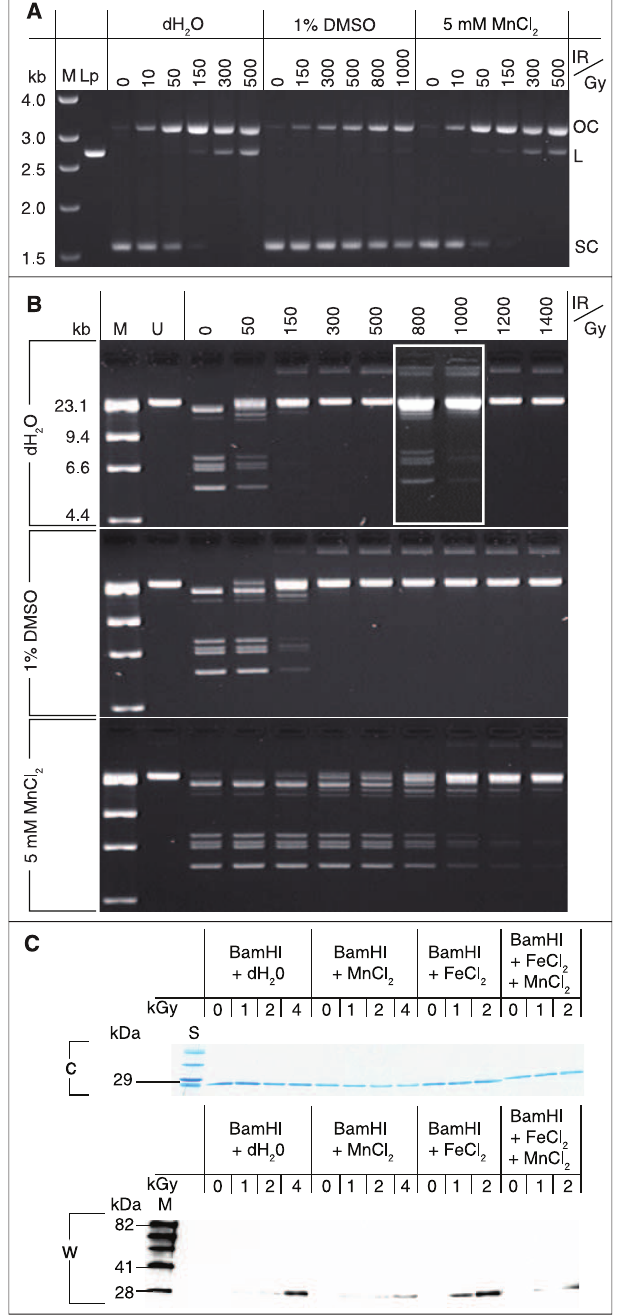
Figure 2. Mn(II) Protects Proteins, but Not DNA, during In Vitro Irradiation (A) DMSO-mediated DNA protection. pUC19 plasmid DNA was irradiated aerobically to the indicated doses in dH 2 O, 1% DMSO (HO (cid:2) scavenger), or 5 mM MnCl 2 , followed by agarose gel electrophoresis (AGE). MnCl 2 and DMSO were prepared in dH 2 O. IR, 60 Co, aerobic at 0 8 C. L, linear (2,686 base pairs); Lp, pUC19 þ BamHI; M, size markers; OC, open circular; SC, supercoiled. (B) Mn(II)-mediated protein protection. BamHI enzyme was irradiated aerobically to the indicated doses in dH 2 O, 1% DMSO, or 5 mM MnCl 2 , and then incubated with k -phage DNA for 1 h at 37 8 C, followed by AGE. Inset (white border), top gel (dH 2 O): BamHI irradiated anaerobically. M, size markers; U, uncut k -DNA. (C) Western blot immunoassay of protein-bound carbonyl groups in BamHI irradiated aerobically to the indicated doses in the presence